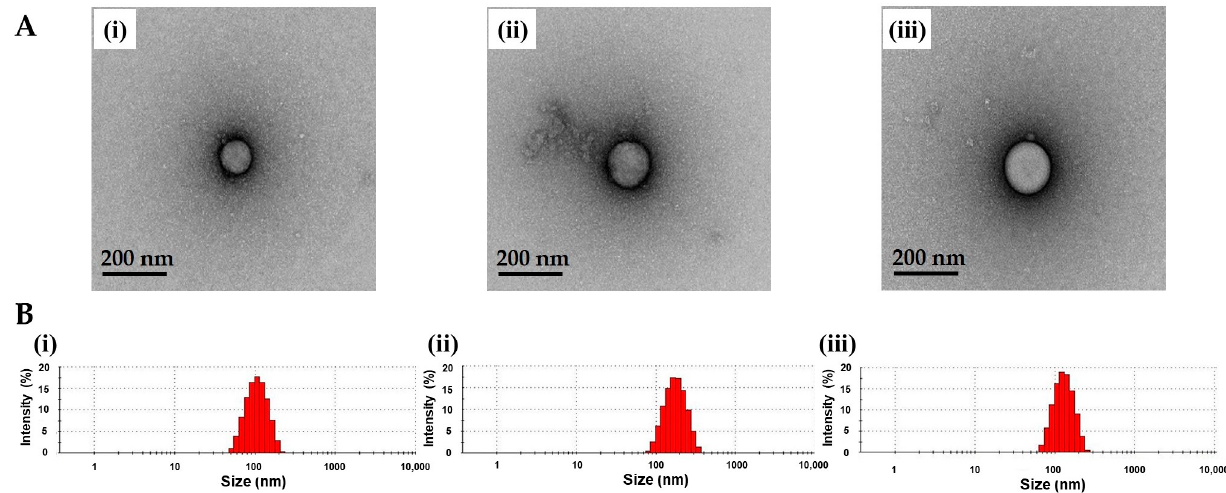
Figure 1. ( A ) TEM images of ( i ) TA-ALN (1:0.1), ( ii ) TA-ALN (1:0.5), and ( iii ) TA-ALN (1:1). ( B ) Size distribution curves of ( i ) TA-ALN (1:0.1), ( ii ) TA-ALN (1:0.5), and ( iii ) TA-ALN (1:1).